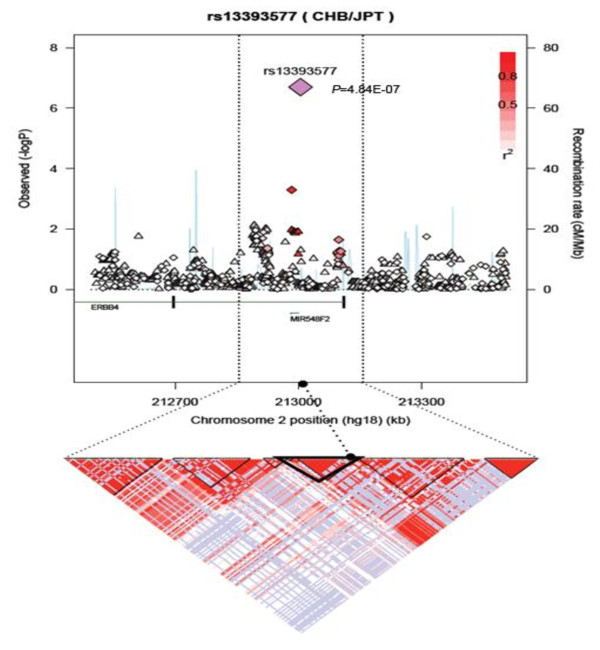
Regional association plot of the 2q34 (rs13393577) locus. The results of association signals (-log P) are shown for directly genotyped (diamonds) and imputed (triangle) single-nucleotide polymorphisms (SNPs) distributed in a genomic region 500 kb to either side of rs1339577. Red reflects the linkage disequilibrium (r2) with the top SNP, and increasing red hue is associated with increasing r2. The blue bars show the recombination rate based on HapMap phase II release 22 JPT and CHB populations. The bottom panels illustrate the locations of known genes. The genomic position is based on the UCSC (University of California at Santa Cruz) Genome Browser assembly, March 2010. CHB, Han Chinese from Beijing; JPT, Japanese from Tokyo.